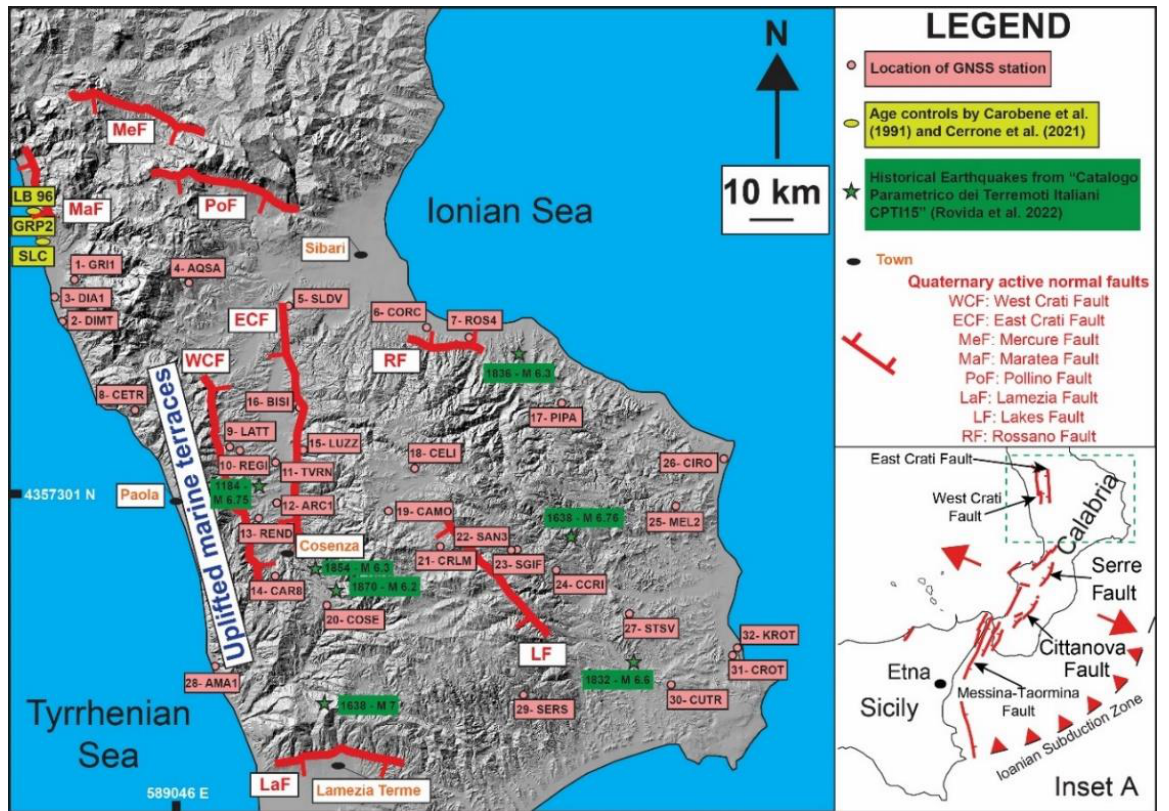
Figure 1. Map of the investigated area. Sketched fault map of the northern Calabria is shown, across the strike of the E-dipping West Crati Fault and where uplifted marine terraces are mapped. Locations of age controls are shown from literature (Table 1). Green-coloured stars show that historical earthquakes occurred within the investigated area. Pink-coloured dots show the network of continuous GNSS stations. Inset A shows Quaternary active normal faults within the Calabrian–Peloritani Arc and the trace of the Ionian Subduction Zone (ISZ)